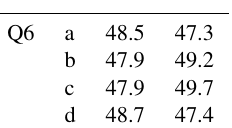
Table 4. The mean age of the stakeholders by the response to the questions if the natural hazards have produced direct damage to the stakeholder.